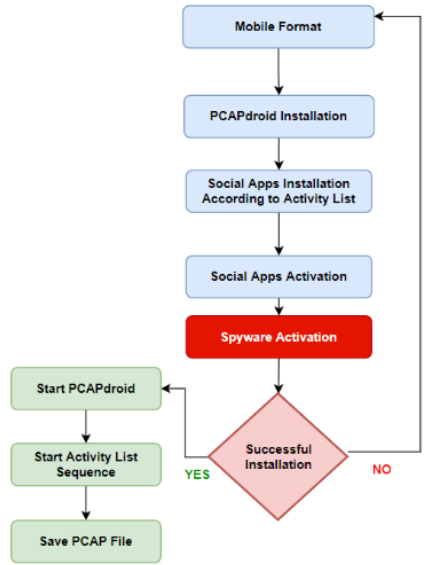
Figure 7. Class B data collection methodology workflow.